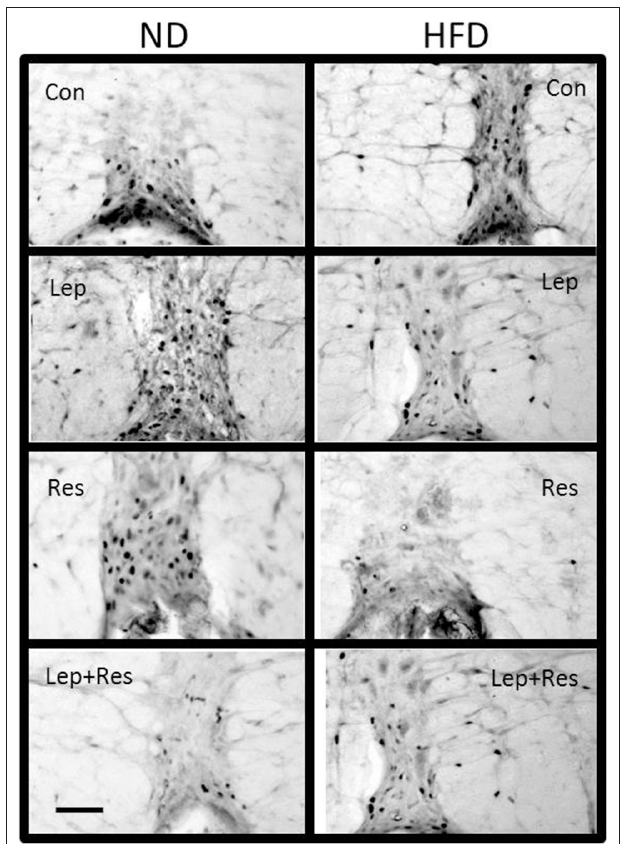
FIGURE 13 | Photomicrographs showing Fos-positive cell nuclei in the Raphe pallidus of rats fed a high fat diet (HFD) and rats fed a normal diet (ND) following centrally administered saline (5 µ l; control), leptin (7 µ g), resistin (7 µ g) or leptin combined with resistin. Scale bar = 100 µ m. The rostrocaudal levels of the sections counted were at ∼ 12.2–12.4mm caudal of bregma. FIGURE 14 | Photomicrographs showing Fos-positive cell nuclei in the